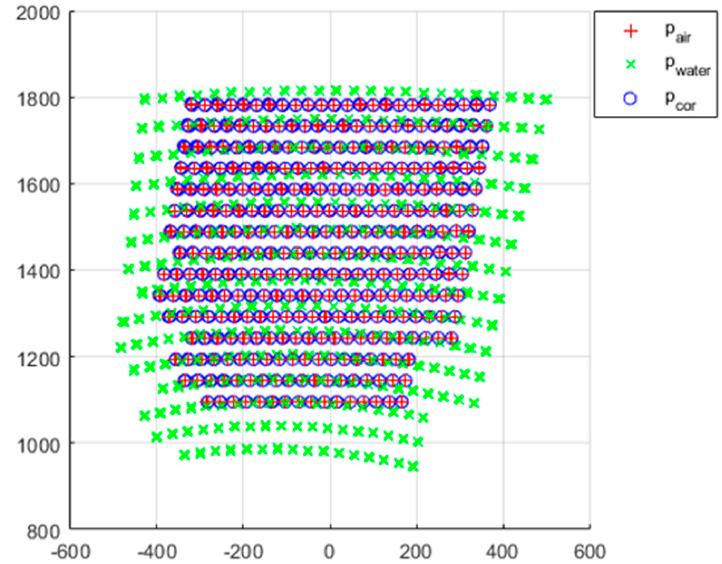
Figure 23. Refraction correction result.